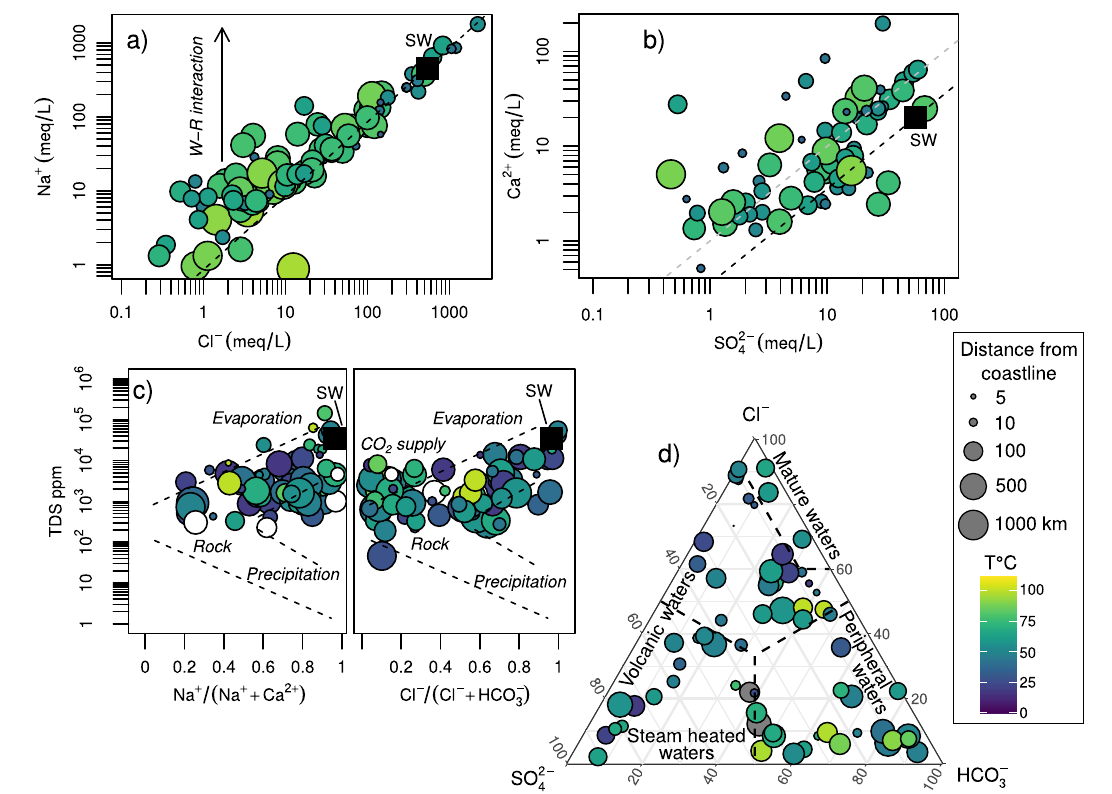
Fig.3|Thechemicalcompositionsofthermalwaters. Chemicalcompositionsof thermal waters in relation to their temperature (pseudo-color scale) and their distancefrom the nearest coastline (size ofthe circles). a Relationship between Cl − and Na + (in meq/L), showing that samples range from a water-rock interaction (W-R) domain to seawater (SW) domain. b The SO 4 2 − and Ca 2+ relationship